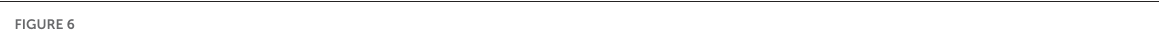
FIGURE6 the empty vector sample is defined as value 1. (C) The cells were transfected with pPB, and 6h later, treated with IFN- α for 3 days. The expression level of EPN3 was determined using Western blot (top) and RT-qPCR analysis (middle). HBV RNA levels were determined by RT-qPCR (bottom). The level of untreated cells is defined as value 1. (D) Cells were transfected with pPB and siEPN3, and 6h later, treated with 1,000 U/ml IFN- α for additional 3 days. The amount of EPN3 was determined using Western blot (top). HBV RNA levels were determined by RT-qPCR (bottom). The HBV level of the siNC transfectant, without IFN- α treatment is defined as value 1. * P < 0.05, ** P < 0.01, *** P < 0.001, **** P < 0.0001. Data are representative of two to three independent